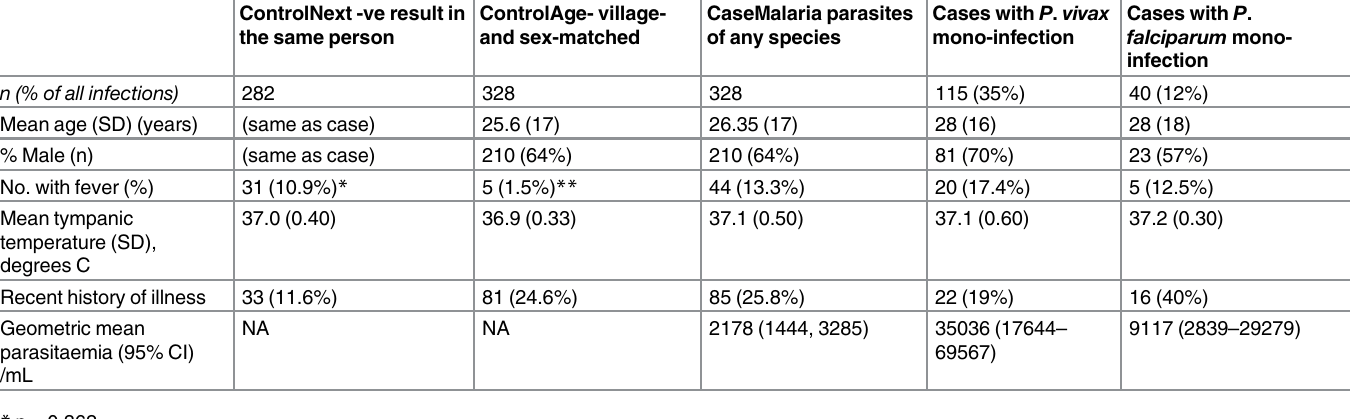
Table 1. Demographic data for same person controls, age- sex- village matched controls and cases, and those for the sub-groups with P . falcipa- rum and P . vivax mono-infections.